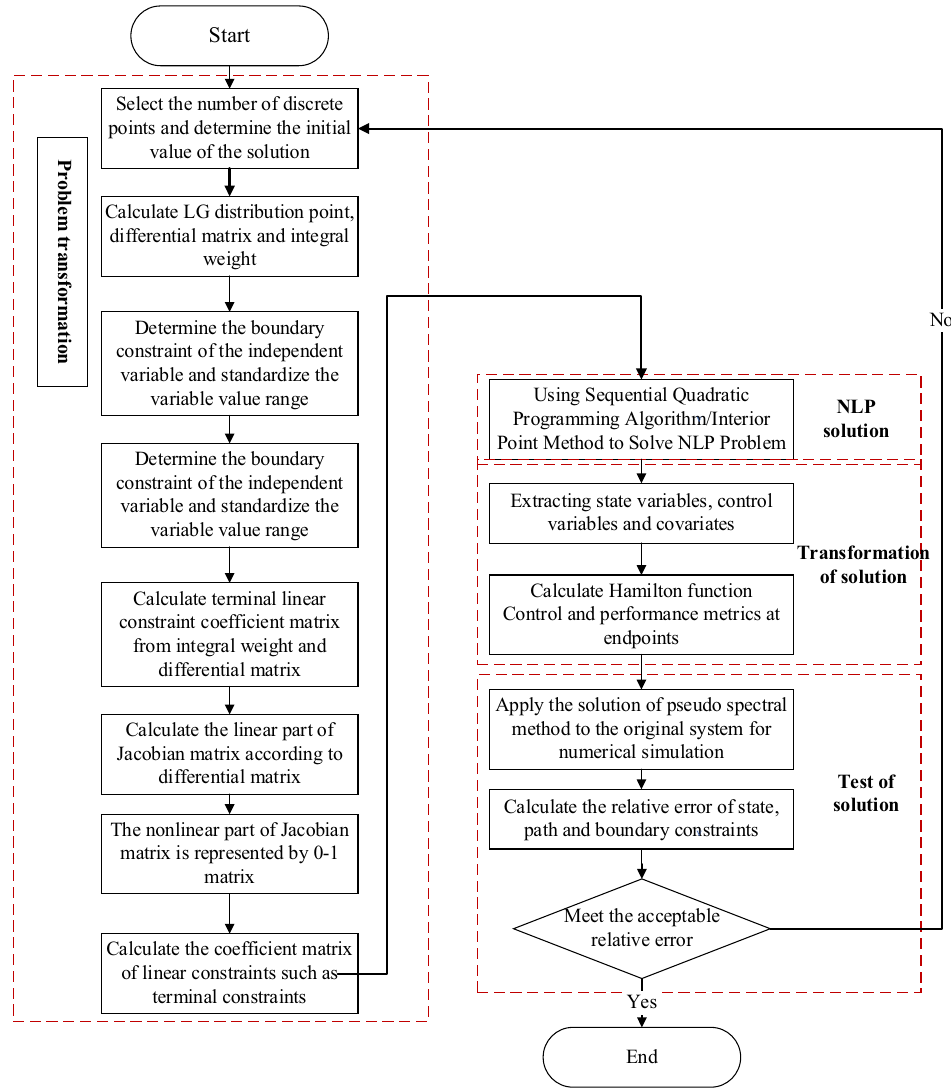
Figure 7. Iterative flow chart of pacing optimization based on Gauss pseudo-spectral